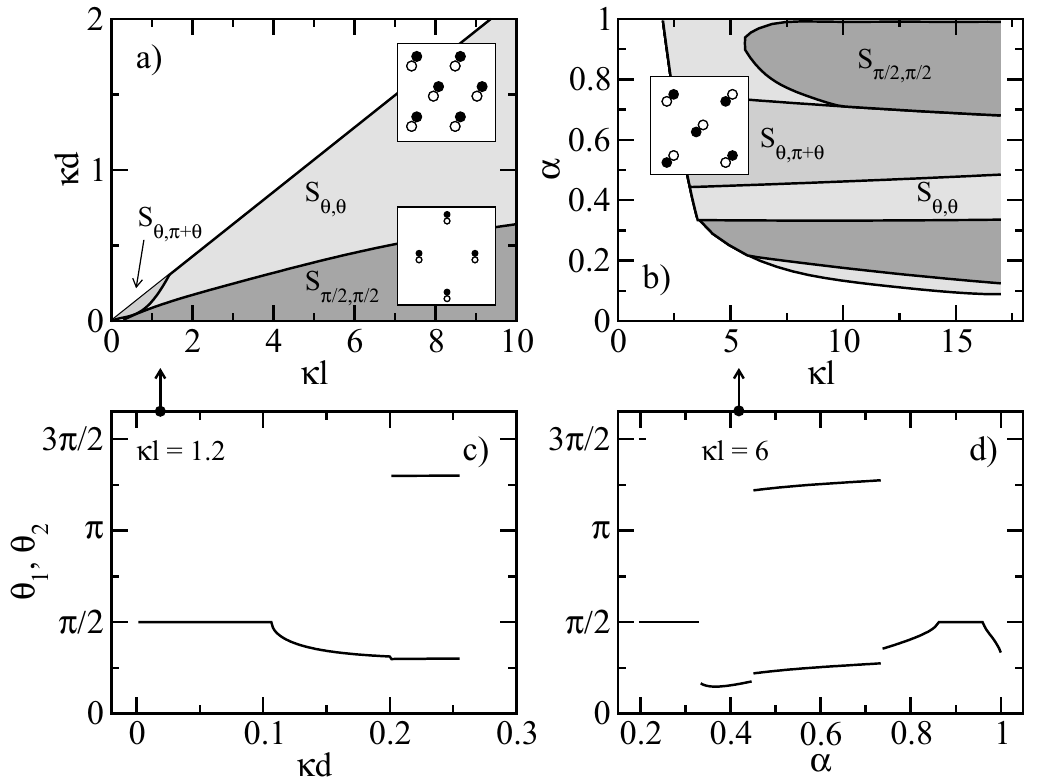
Fig. 7 – Phase diagram for opposite charged dimers on a triangular lattice for (a) α = 0 . 8 and (b) κ d = 0 . 5. The insets show the representative stripe configurations. The parameter dependence of bipartite angles along the κ l . 2 and κ l = 1 = 6 lines of phase diagrams (a) and (b) is shown in (c) and (d), respectively.